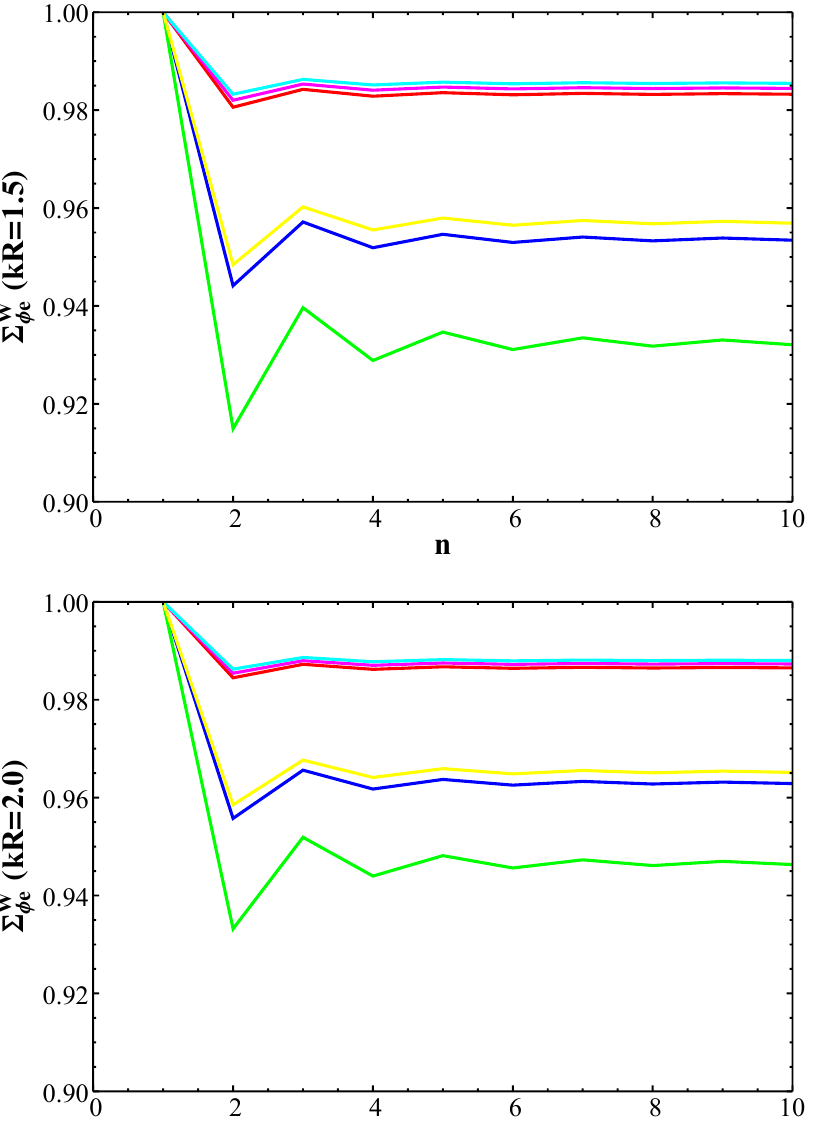
Figure 18 . (Top) The value of the sum Σ W defined in eq. (4.11), which encapsulates the dependence φe of the DM-electron scattering cross section on parameters of the model of the extra dimension, truncated at finite n , assuming kR = 1 . 5 for various choices of (( kR ) τ, a W ) =(1/2,1/2) [red], (1/2,1) [blue], (1/2,3/2) [green], (1,1/2) [magenta], (3/2,1/2) [cyan] and (1,1) [yellow], respectively. (Bottom) As in the previous panel, but assuming kR = 2 . 0